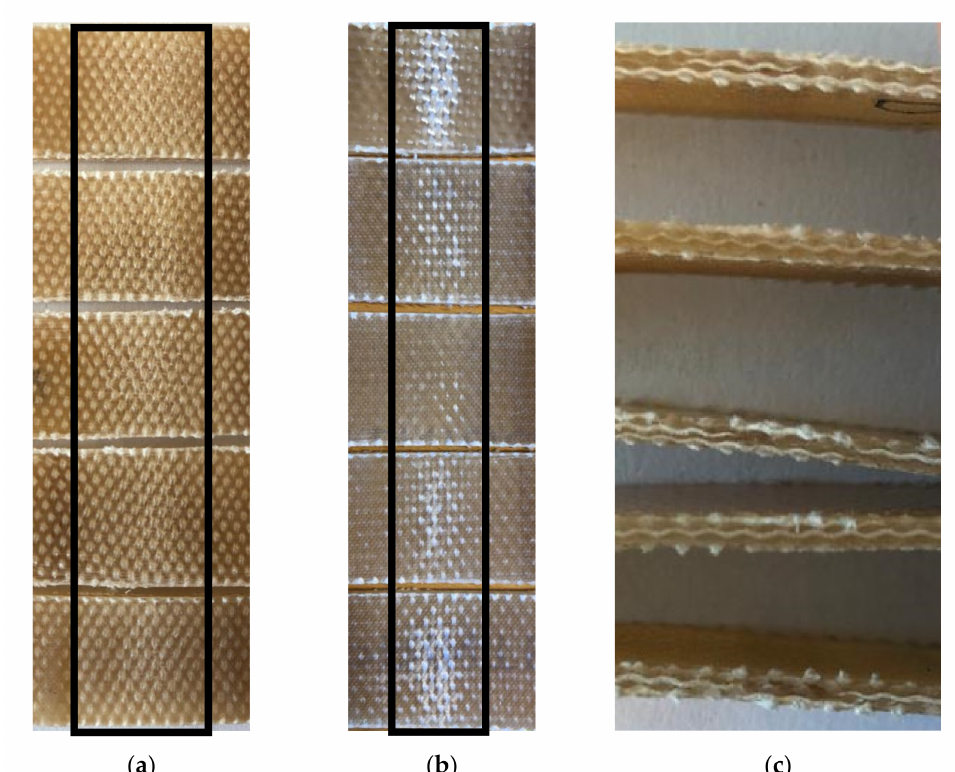
Figure 3. Digital images of ( a ) the middle of samples’ bottom surfaces having undergone tension, ( b ) the middle of samples’ top surfaces having undergone compression and a ( c ) cross-sectional view of the bent samples right in the middle after flexural tests.